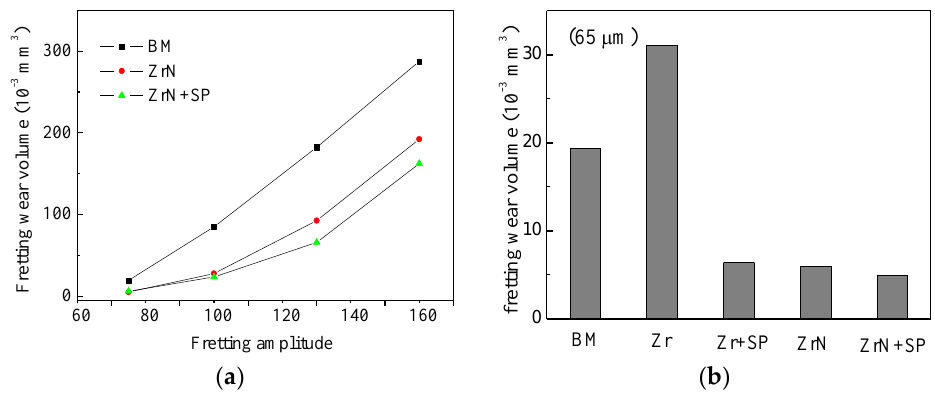
Figure 14. ( a ) Wear volume loss at different slip amplitudes and ( b ) comparison at 65-μm slip amplitudes.